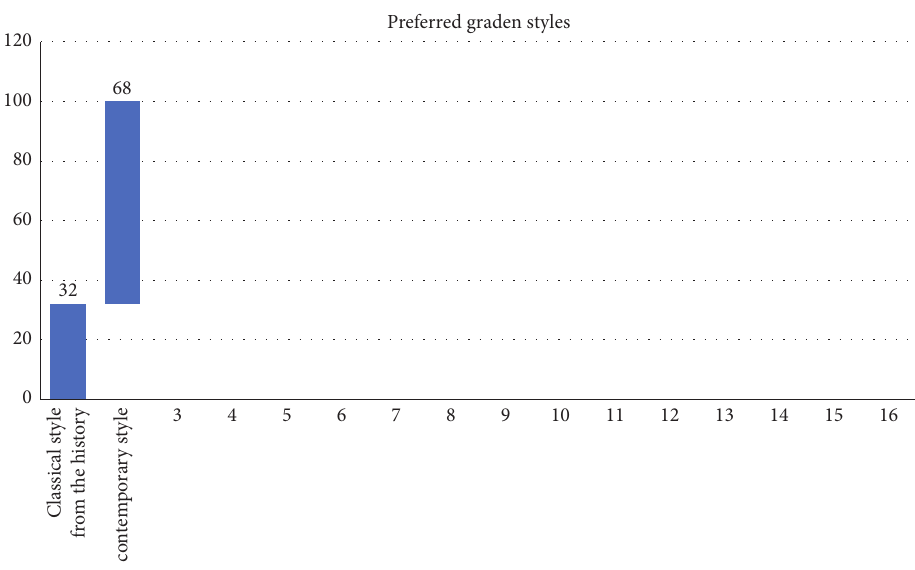
Figure 5: The most effective style for